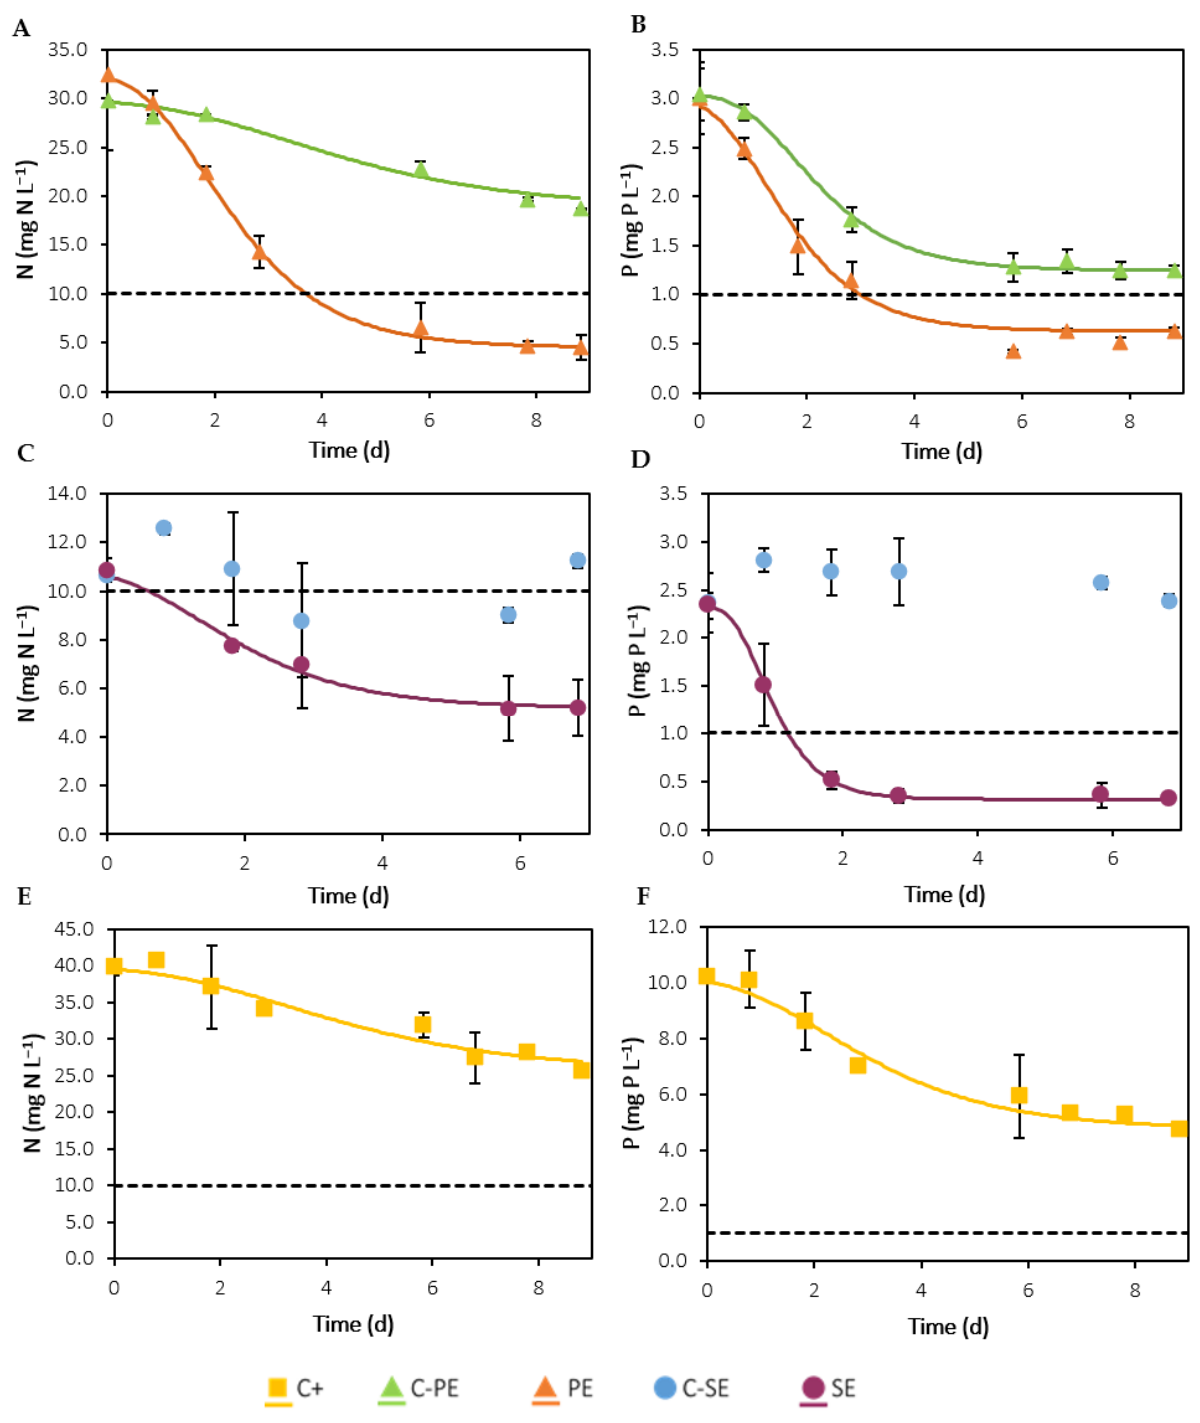
Figure 4. Time-course evolution of nitrogen ( A , C , E ) and phosphorus ( B , D , F ) concentration in assays with C-PE/PE ( A , B ), C-SE/SE ( C , D ) and C+ ( E , F ). Error bars correspond to the standard deviation of the mean obtained from two independent experiments. The filled lines represent the model fit of the modified Gompertz model to the experimental data. The horizontal dashed lines correspond to the EU legislation limits in discharged effluents: 10 mg N L − 1 and 1 mg P L − 1 .